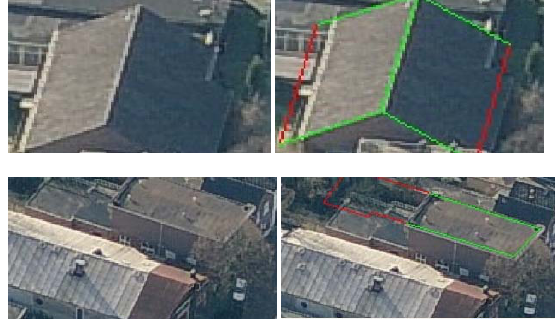
Figure 11. Building models with some correct and wrong edges - red lines are correctly identified as wrong -